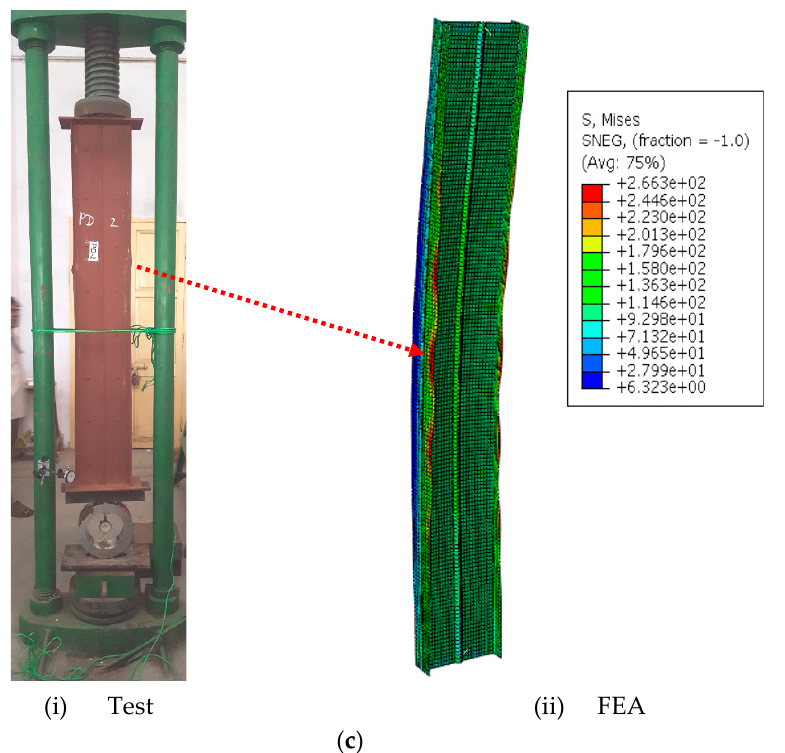
Figure 16. Relationship between the various failure modes of channel sections. ( a ) ISSCS-5. ( b ) BISCS-1. ( c ) BISCS-2.